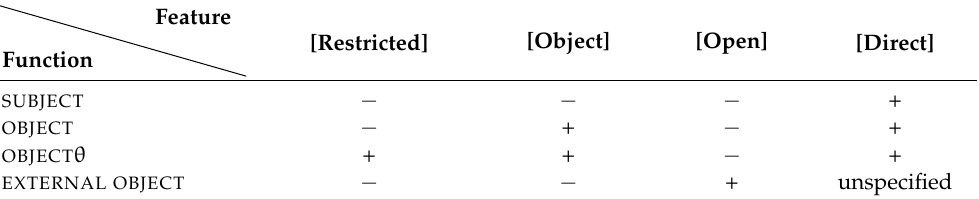
Table 4. Feature matrix of Warlpiri, adapted from Simpson (1991, p. 419).